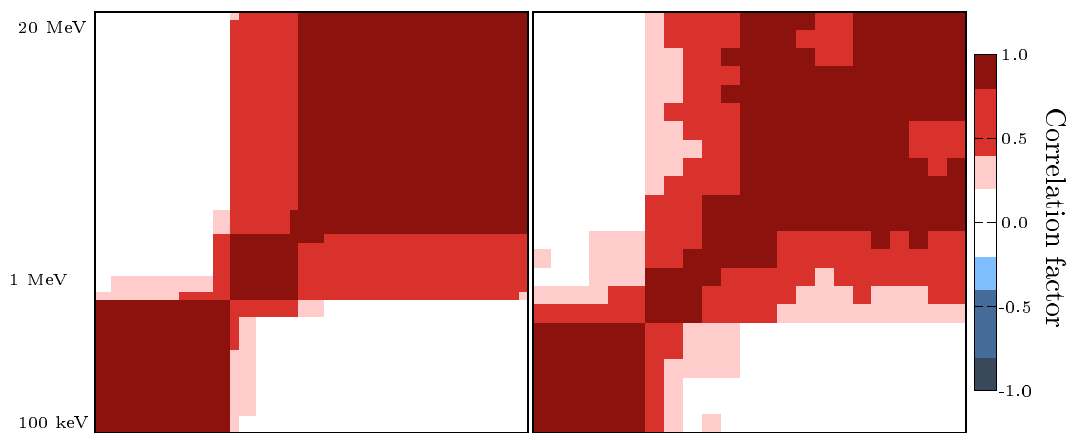
Figure 2: Correlation matrices for 120 Sn based on variation of model parameters (left) and models (right)